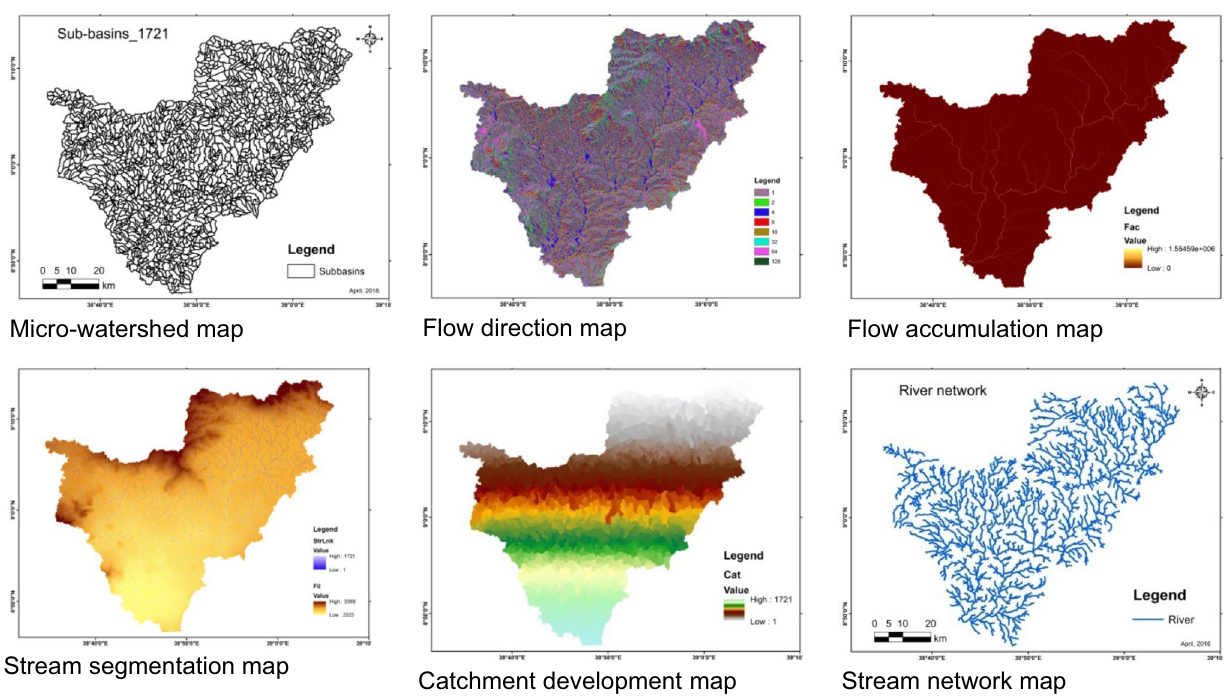
Fig. 10 Different parameter maps for the flood risk and runoff discharge. Source Addis Ababa Rivers, and Riversides Climate Change Adapta-